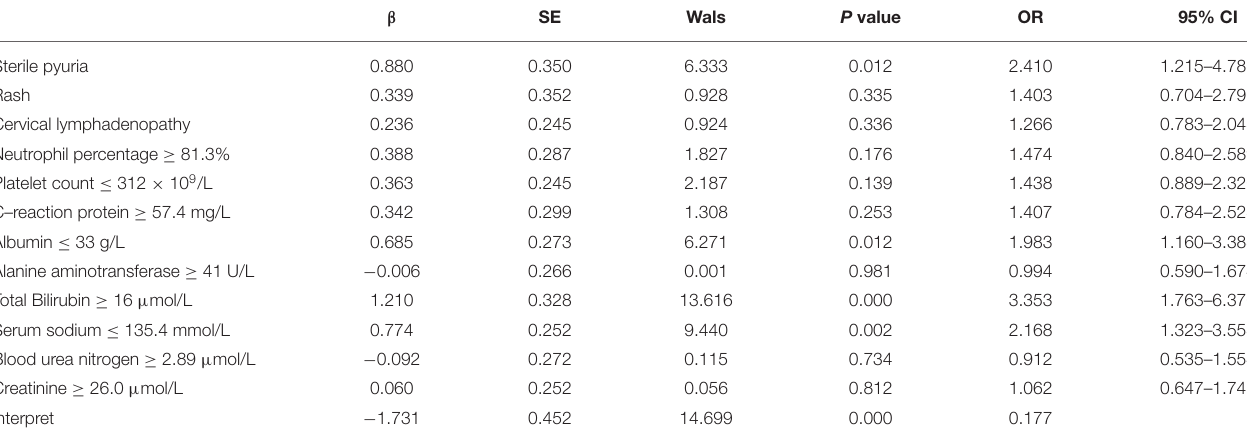
TABLE 4 | A multivariate logistic regression model for intravenous immunoglobulin resistance in patients with Kawasaki disease. β SE